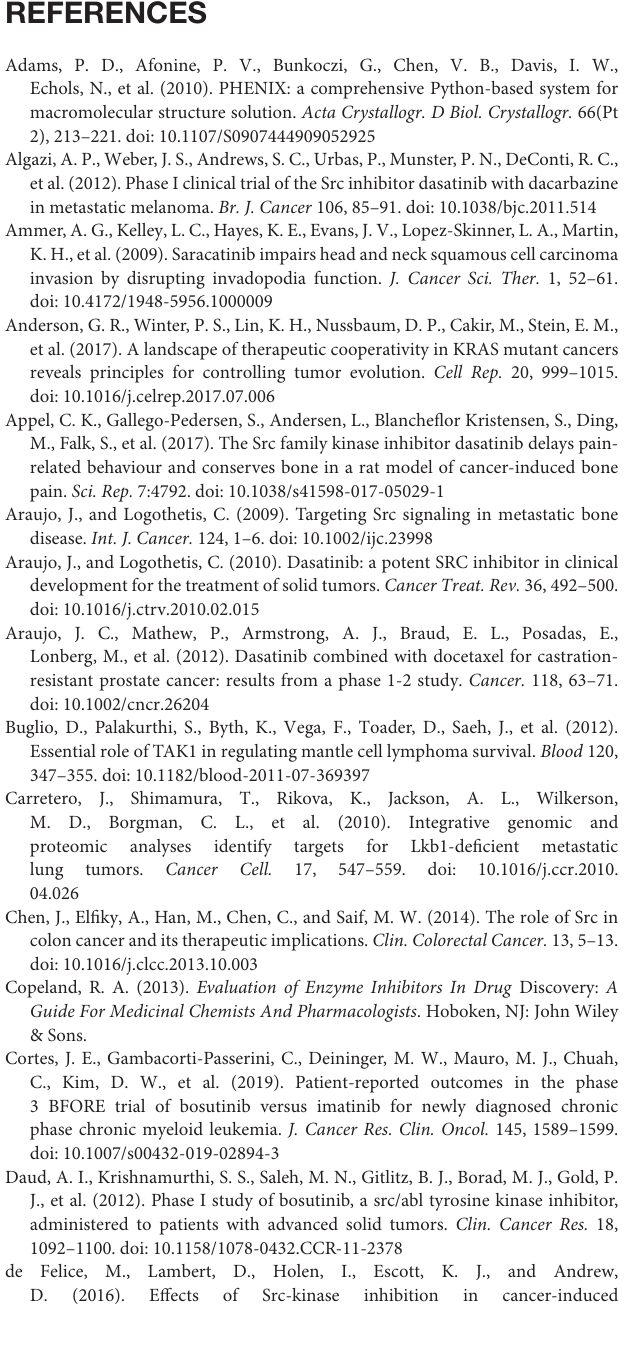
Figure S1 | Src kinase domain architecture and location of targetable cysteine the p-loop.